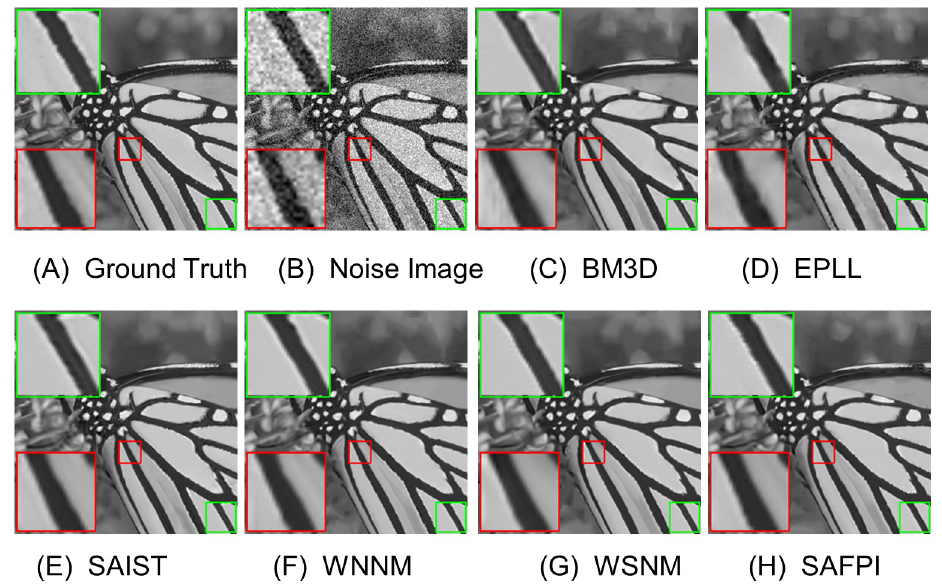
Fig 5. Denoising results on image Monarch by different methods (noise level σ n = 30). (A) Ground Truth (B) Noisy Image (C) BM3D, PSNR = 28.36 (D) EPLL, PSNR = 28.35 (E) SAIST, PSNR = 28.03 (F) WNNM, PSNR = 28.94 (G) WSNM, PSNR = 29.02 (H) SAFPI, PSNR = 29.09.